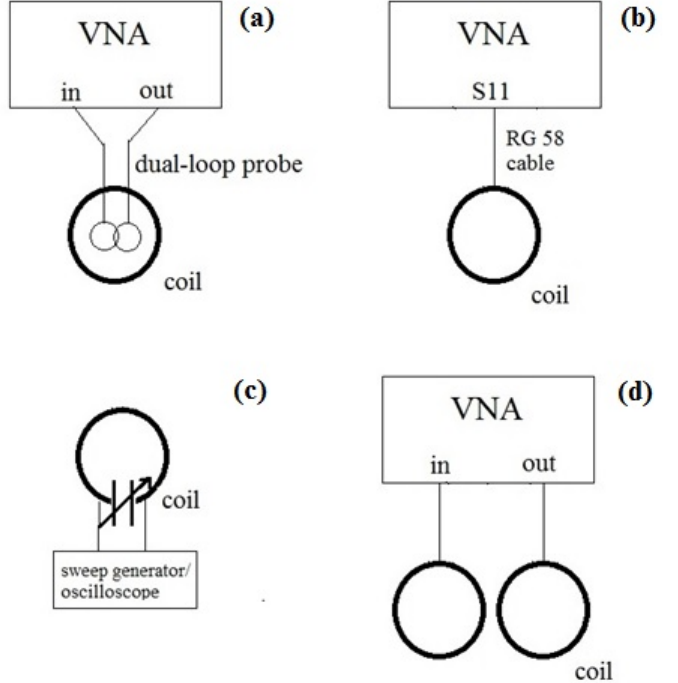
Figure 7. Experimental measurement setups: ( a ) Coil #1; ( b ) Coils #3–5; ( c ) Coil #2; ( d ) Coil #6.